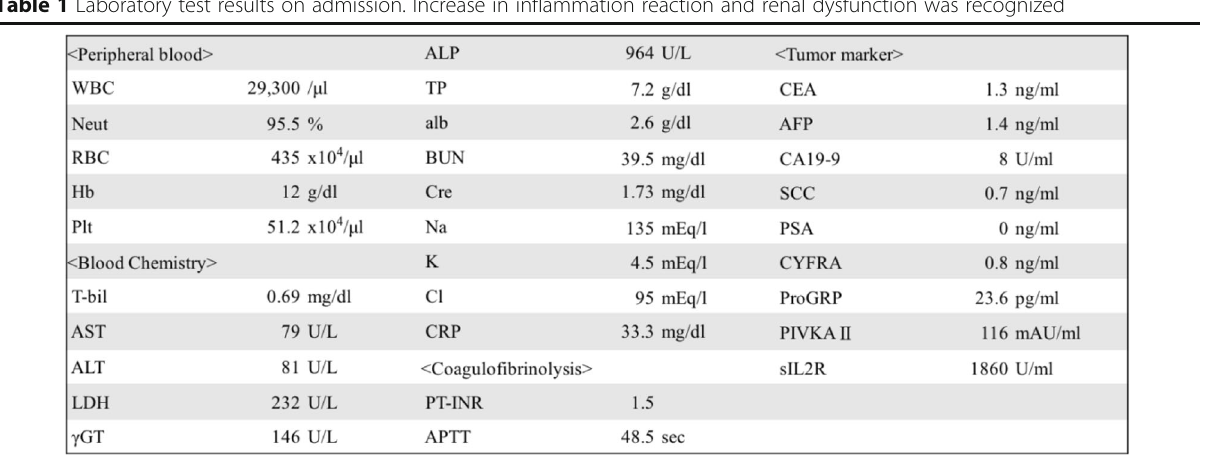
AFP alpha-fetoprotein, Alb albumin, ALP alkaline phosphatase, ALT alanine aminotransferase, APTT activated partial thromboplastin time, ST aspartate aminotransferase, CEA carcinoembryonic antigen, Cl chloride, Cre creatinine, CRP C-reactive protein, CYFRA cytokeratin fragment, Hb hemoglobin, K potassium, LDH